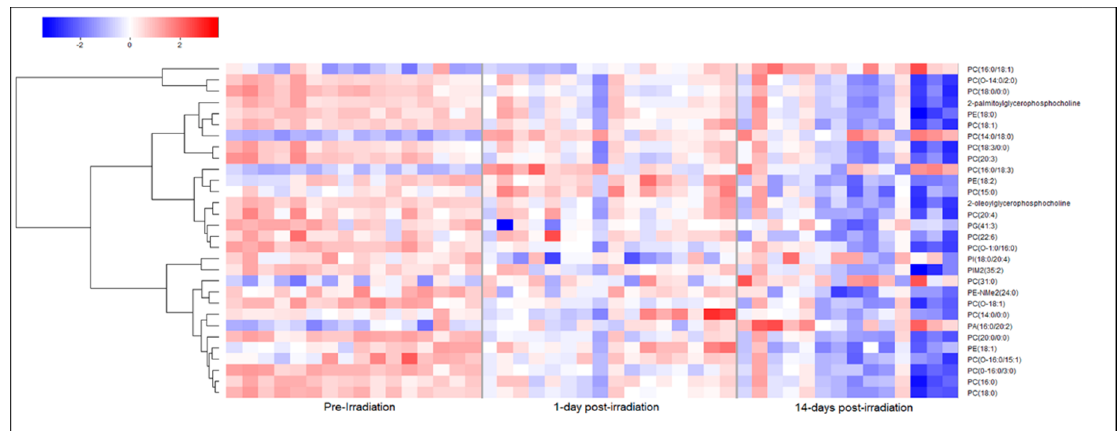
Figure 6. NHPs exposed to 6.5 Gy 60 Co γ -radiation experience significant dyslipidemia in plasma. Heat map visualizing an initial up-regulation of a significant number of lipid classes 1-d post-irradiation in NHP plasma samples. Nearly all lipids that were significantly changed were down-regulated after 14-d post-irradiation when compared to pre-irradiation levels, suggesting an initial increase in lipid synthesis followed by a delayed systemic injury response.